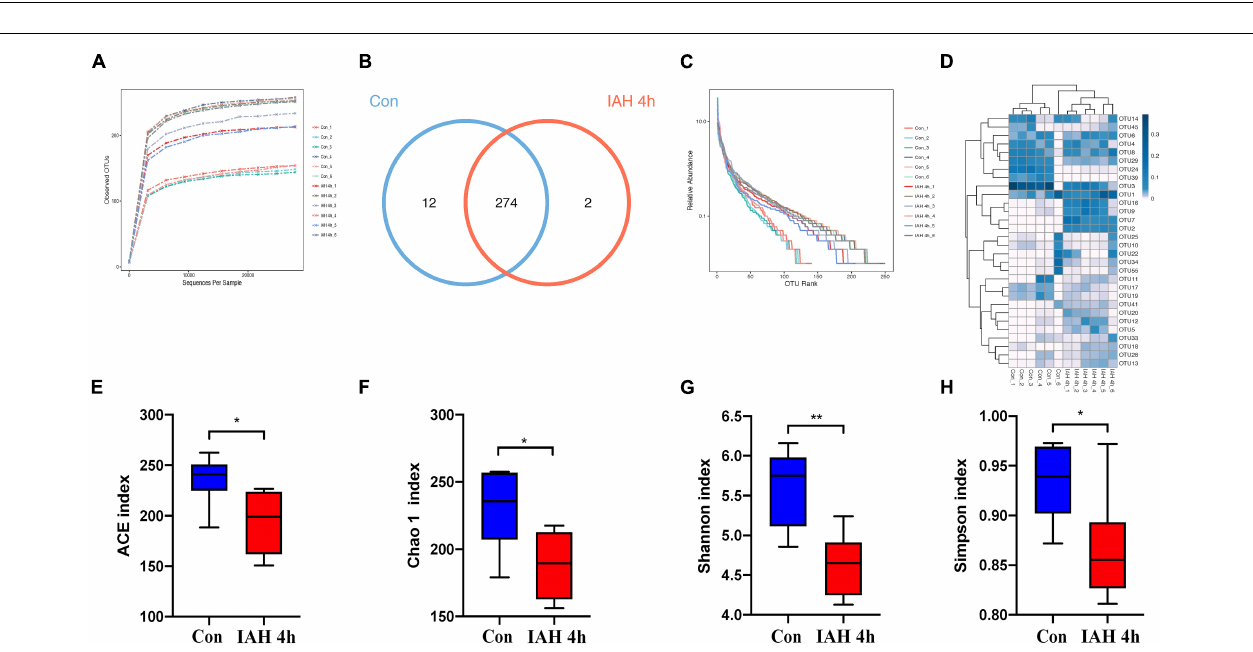
FIGURE 1 | Liver injury induced by IAH. (A,B) The levels of plasma ALT and AST after IAH intervention for 4 h. (C) Representative liver morphology. (D,E) HE staining and the histological score of liver injury after IAH intervention for 4 h (mean ± SD. **** p < 0.0001; Con group vs. IAH 4-h group; n = 6 per group).